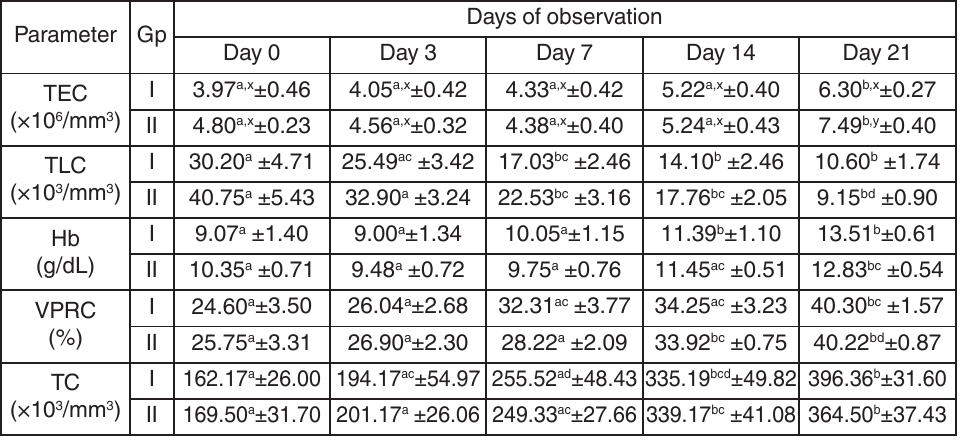
table 1. Haematological parameters on different days of observation in dogs affected with open and closed-cervix pyometra Parameter